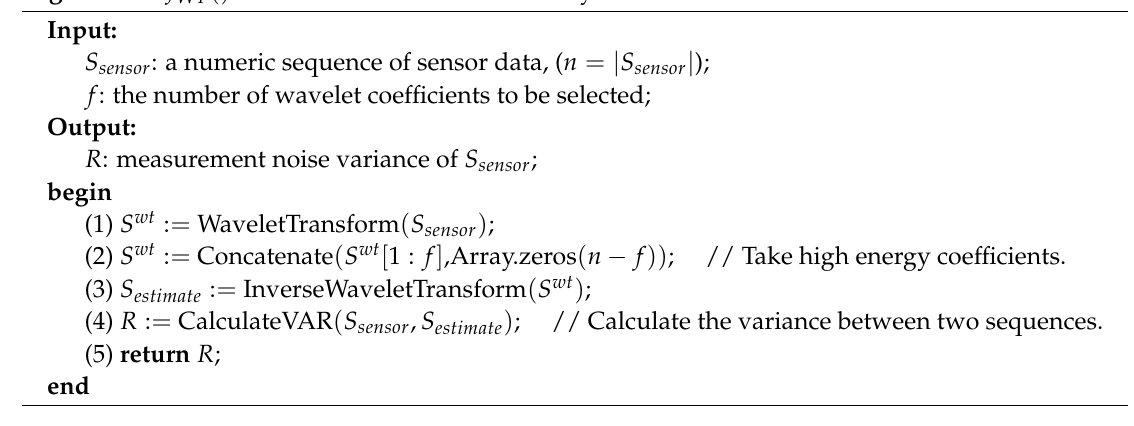
Algorithm 2 f WT () : Measurement noise variance by wavelet